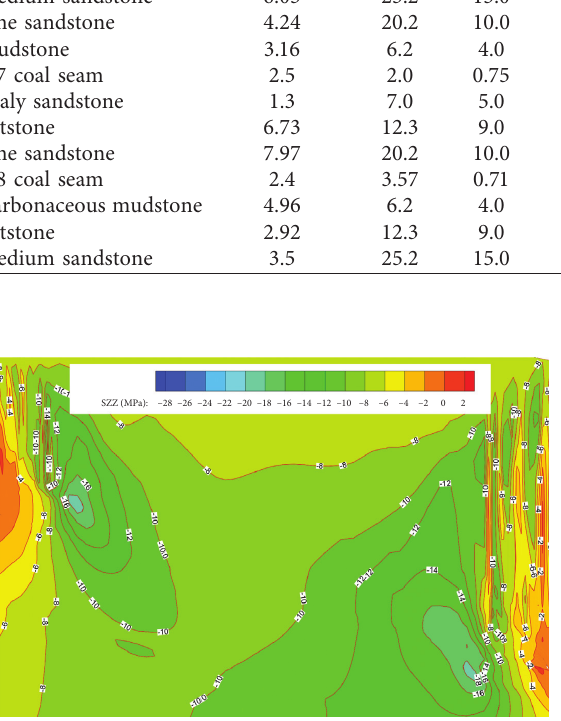
Figure 7: Distribution of abutment pressure in the gob side of the soft coal seam.